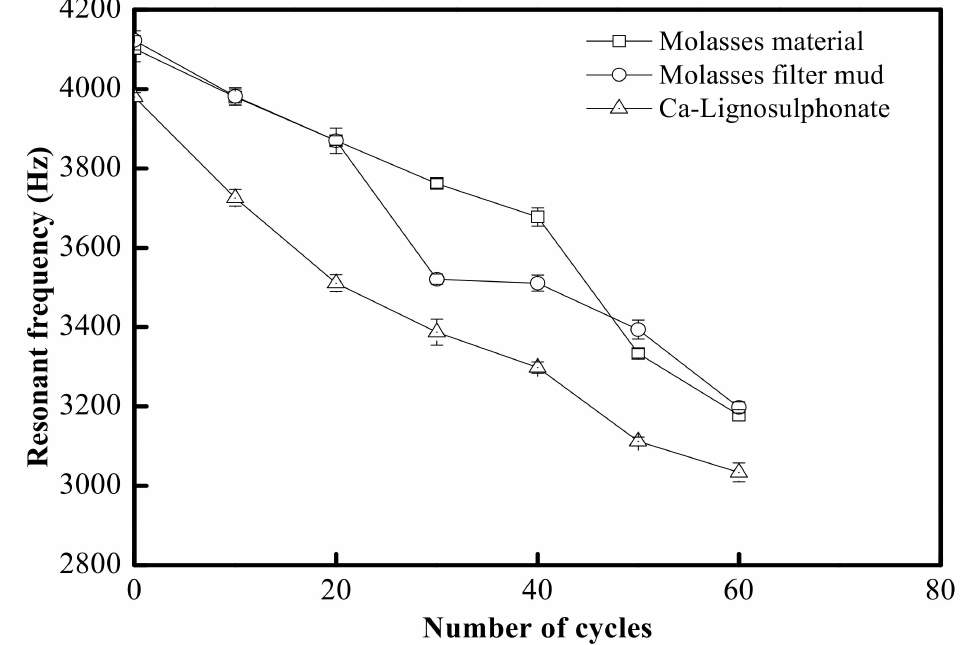
Figure 6. Variation of resonant frequency with wetting–drying